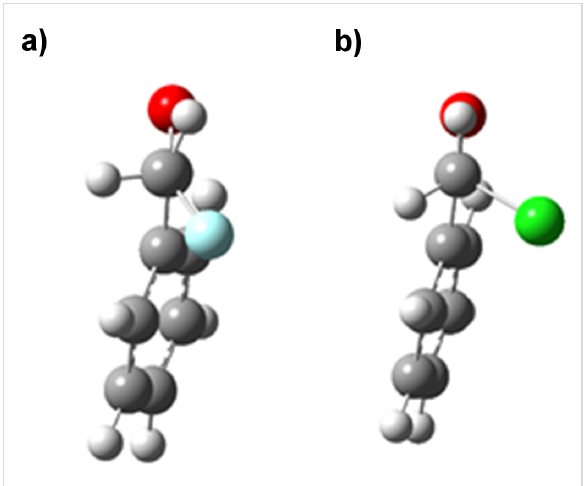
Figure 2: Optimised gas phase geometries of (a) α -fluoroacetophe- none and (b) α -chloroacetophenone emphasising the smaller dihedral angle preferred by the chlorinated derivative.